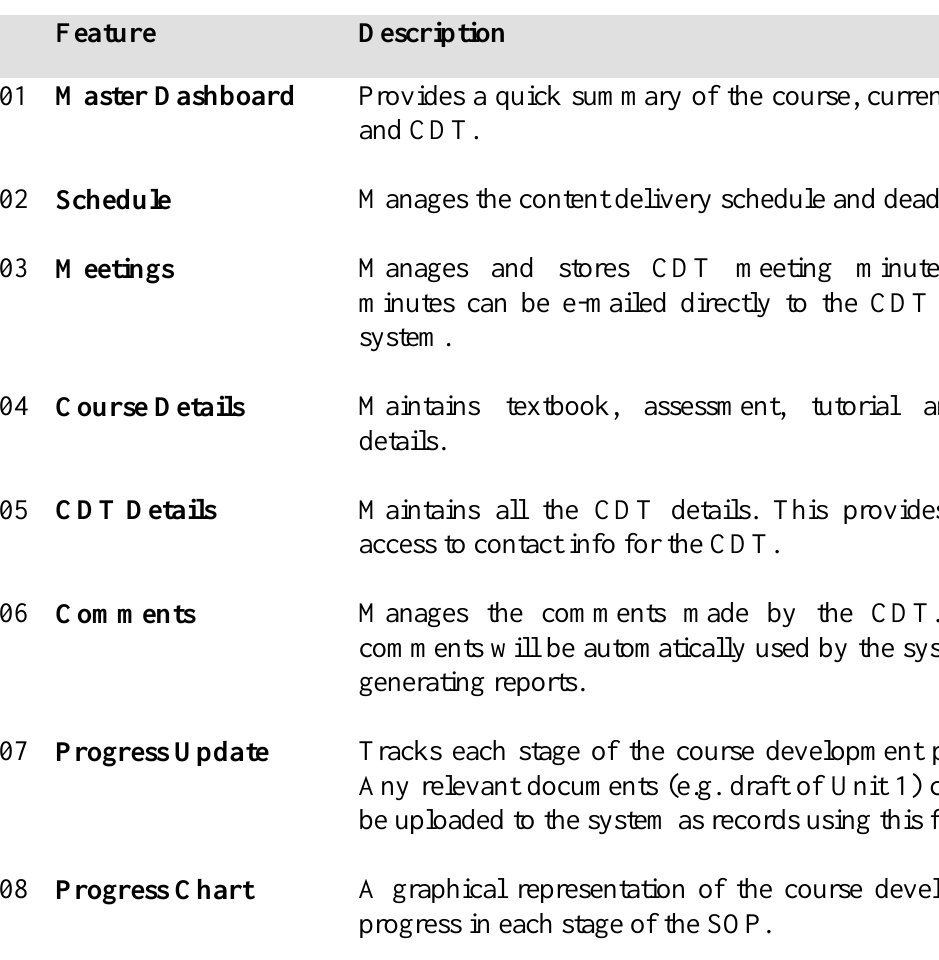
Table 1: Key features of